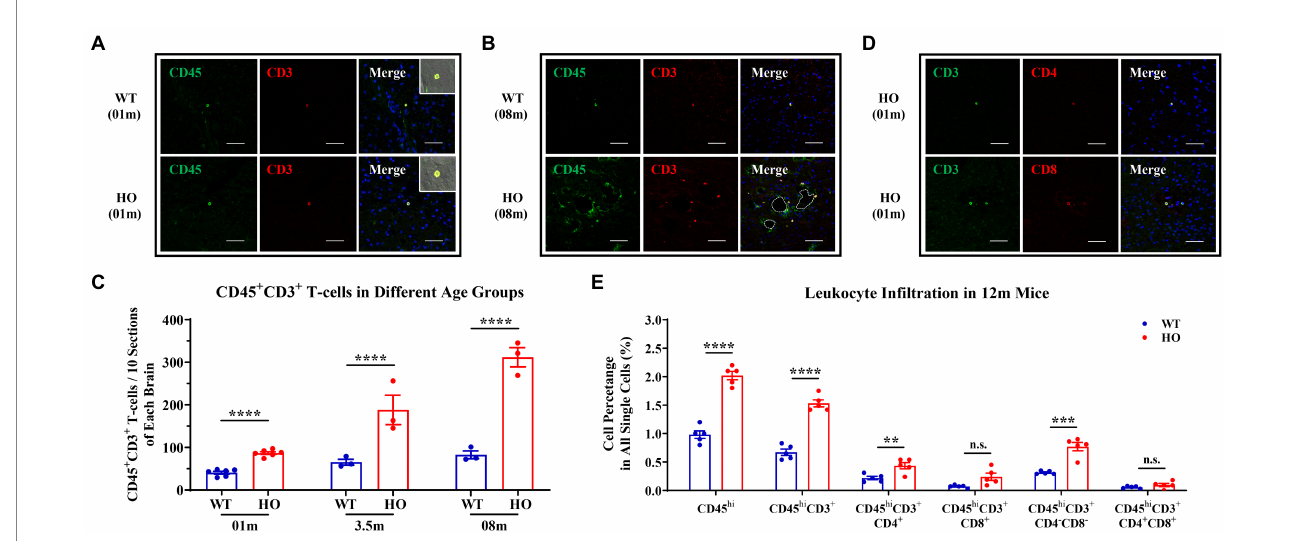
FIGURE 1 Increased CNS Infiltration of T-Cells and Their Subpopulations in Slc20a2 -HO Mice. (A) CD45 + CD3 + T-cells in the brain parenchyma of 1-month-old Slc20a2 -WT and -HO mice. (B) Accumulation of T-cells around the calcification in 8-month-old -HO mice. Dashed lines indicate the outline of the calcified spots. (C) Absolute number of T-cells in the brain of -WT and -HO mice at 1-, 3.5-, and 8-month-old (Data are shown as mean ± SEM; 1 month, n = 6 pairs; 3.5 months, n = 3 pairs; 8 months, n = 3 pairs; 10 equally spaced sections covering entire brain with three biological replicates). (D) CD4 + and CD8 + T-cells in brain parenchyma of 1-month-old -HO mice. (E) Leukocyte immunophenotyping in 12-month-old -WT and -HO mice. Scale bar, 40 μ m. **** p < 0.0001; *** p < 0.001; ** p < 0.01; n.s., not statistically